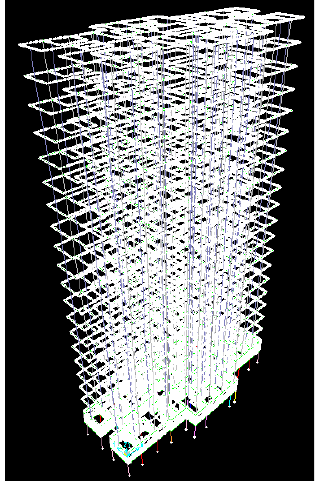
Figure 7. Building discretized in SAP2000 (fully-fixed base – model